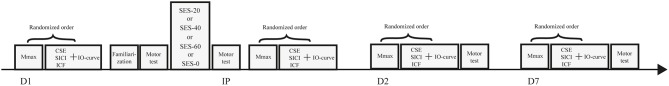
Schematic overview of the experimental design. Baseline measures including maximal compound action potentials (Mmax), corticospinal excitability (CSE), short-interval intracortical inhibition (SICI), intracortical facilitation (ICF), and input-output curves (IO curve) were performed before familiarization of the visuomotor task and after completion of one of four somatosensory electrical stimulation (SES) interventions. Baseline measures were repeated immediately post SES (IP), on day 2 (D2), and on day 7 (D7).